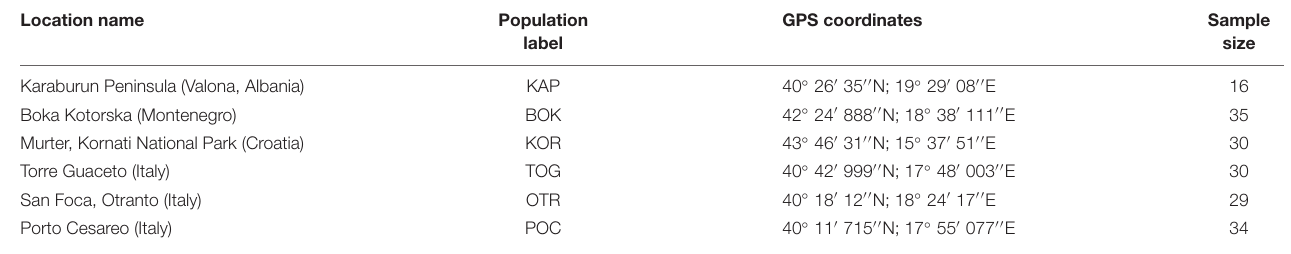
TABLE 1 | Location of Gibbula divaricata